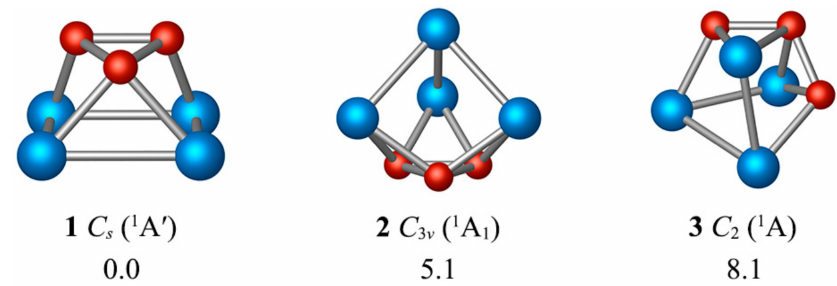
Figure 2. PBE0/def2-TZVP structures of the three lowest-lying energy isomers of B 3 Al 4 + . The energetically closest isomer is only 5.1 kcal mol − 1 above the global minimum and consists of an Al 4 tetrahedron. The third isomer differs from the putative global minimum by exchanging a B atom for an Al atom and is 8.1 kcal/mol higher in energy. Note